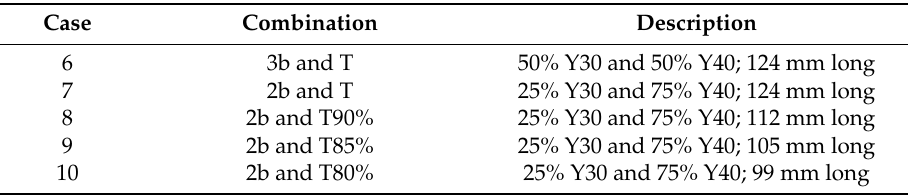
Table 4. Divided ferrites and different length of T-shaped pole